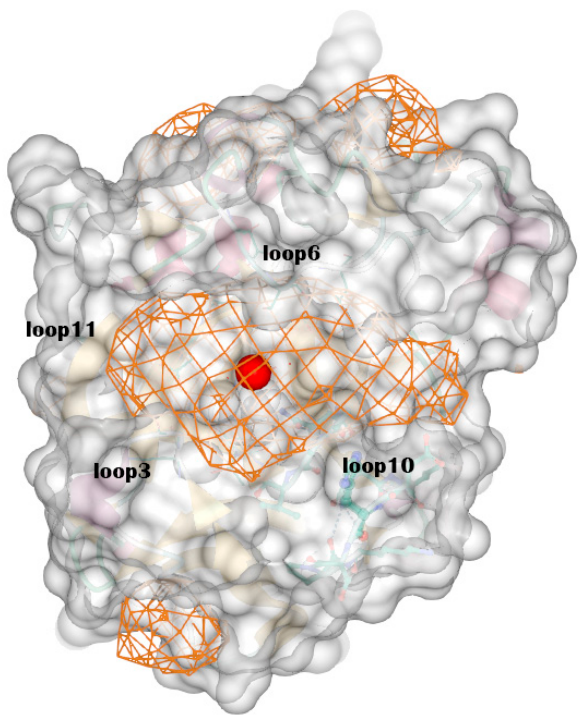
Figure A2. The optimal binding site the DeepSite found. It is surrounded by loop 3, loop 6, loop 10 and loop 11. The chitosanase is shown by transparent surface and the possible binding sites are shown by grid. The red ball represents the center of binding site.